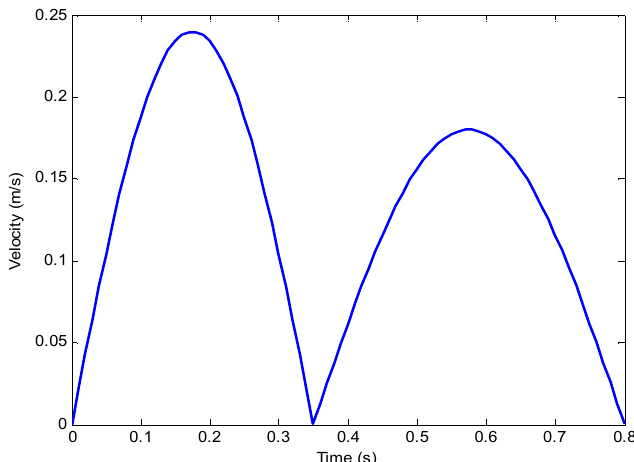
Figure 2. Flow velocity waveform in the inlet used in the simulation for the flow analysis.